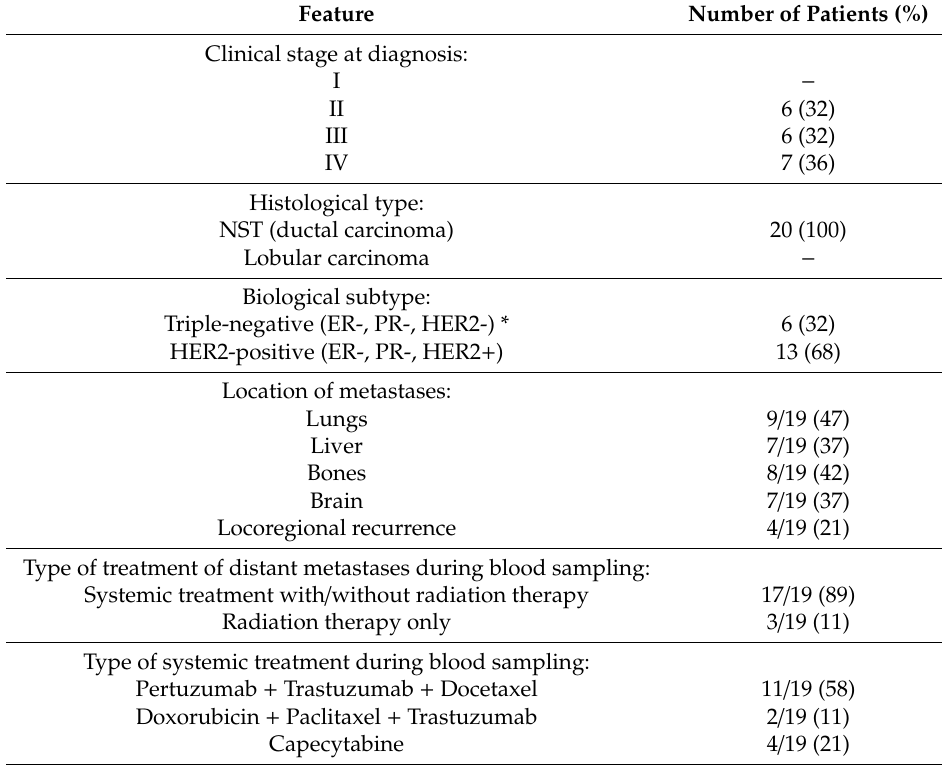
Table 2. Characteristics of patients with clinical stage IV breast cancer ( n =